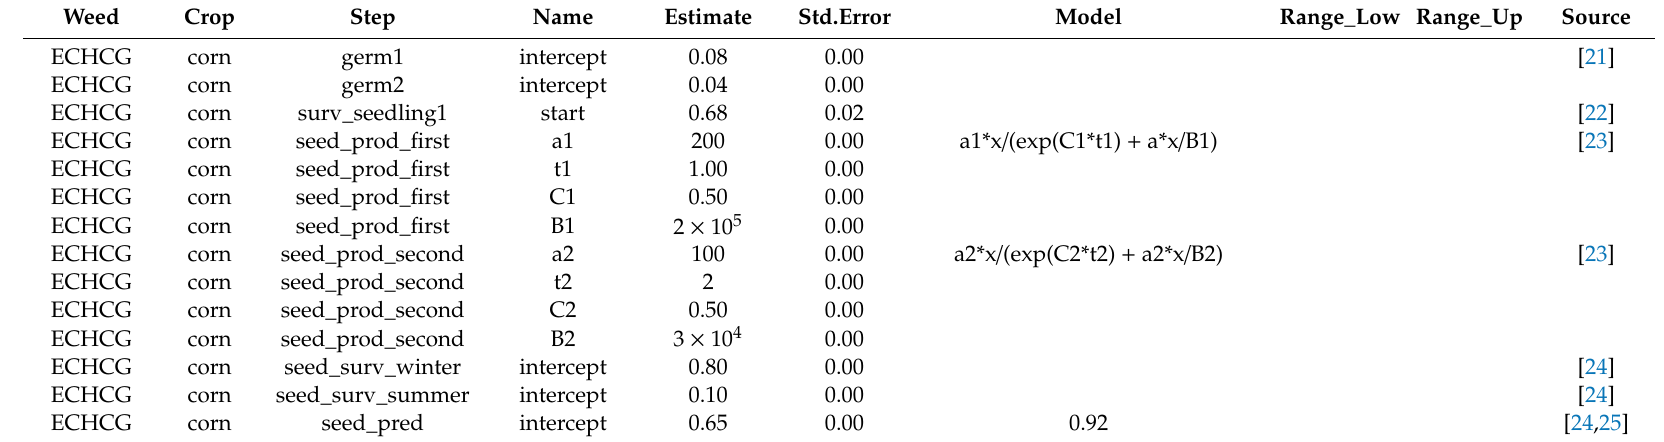
Table 1. Parameters for a population dynamic simulation of Echinochloa crus-galli [15]. These include in this case proportions with variation (here, only for surv_seedling1) or without (e.g., germ1) and hyperbolic functions (e.g.,